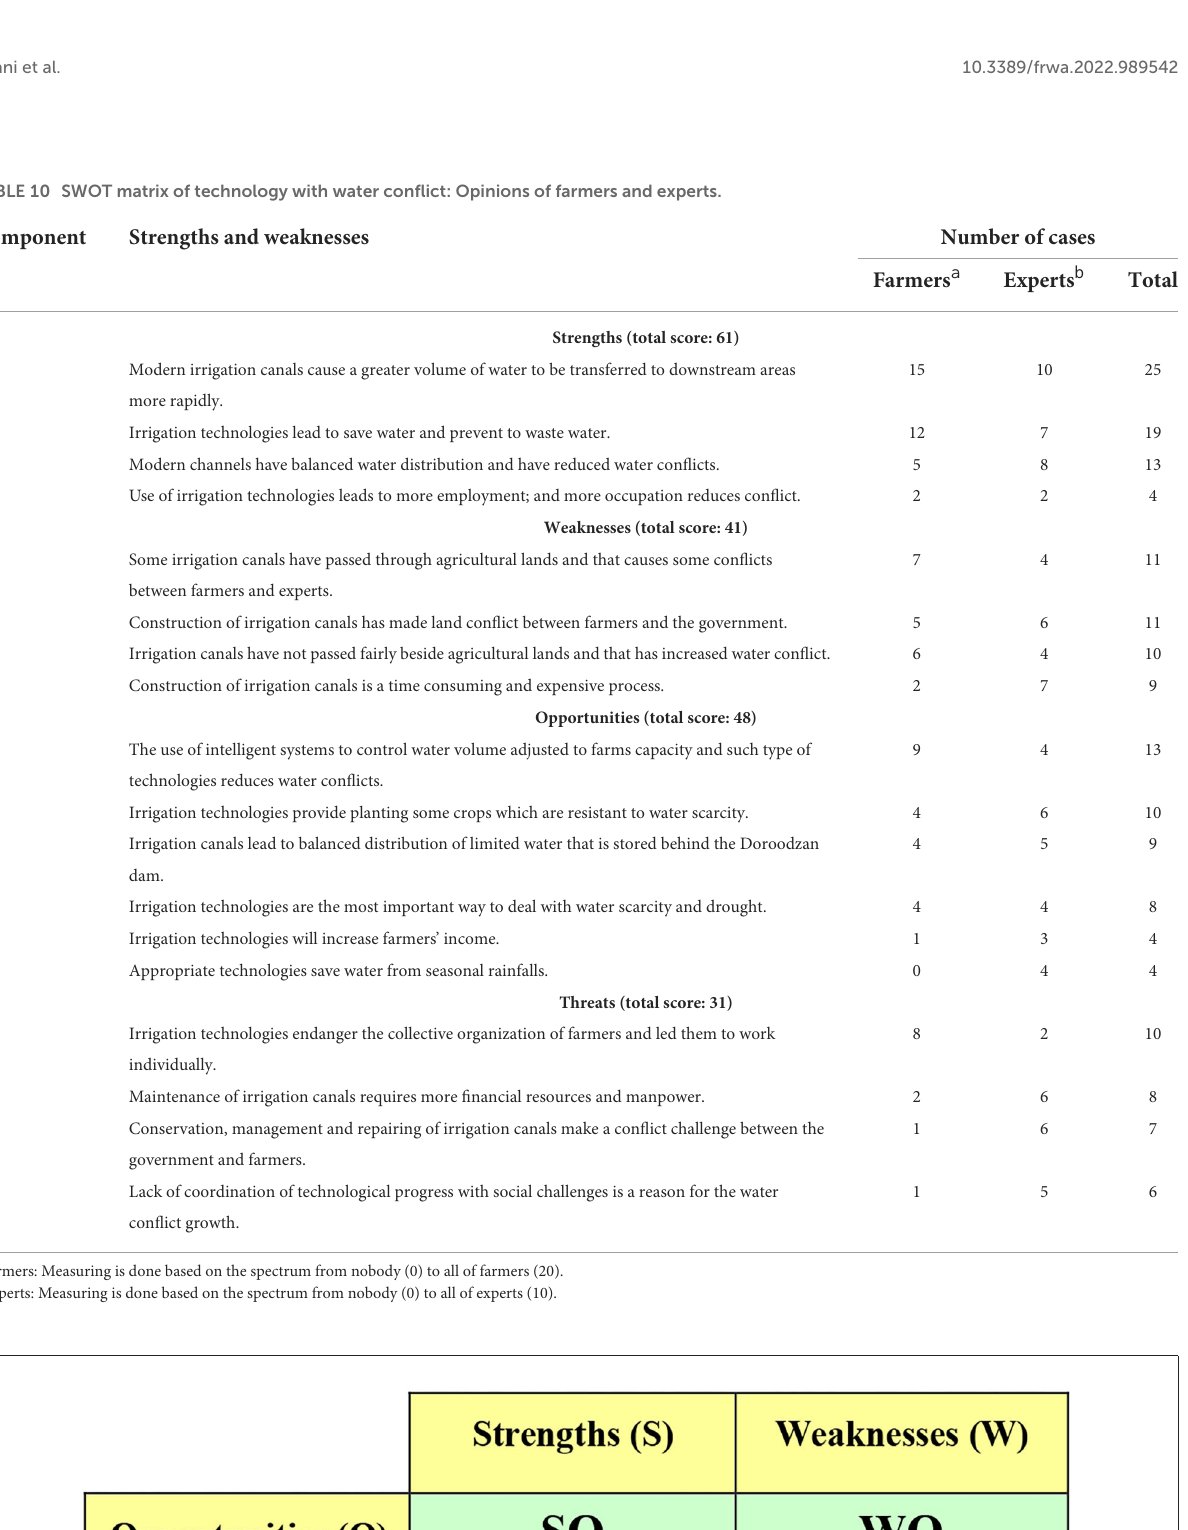
FIGURE3 The resulting strategies from the crosses matrix of strengths, weaknesses, opportunities, and